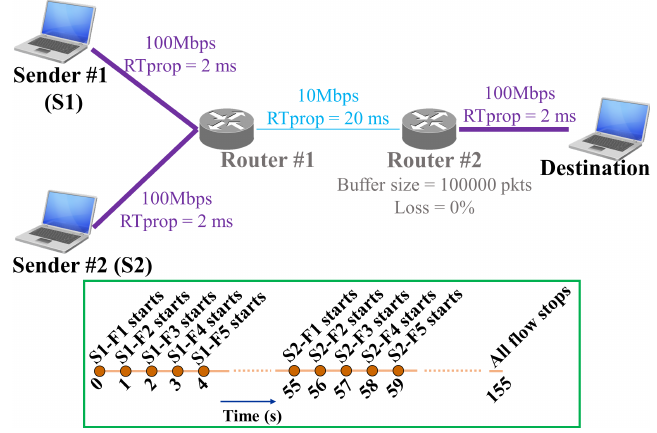
Figure 2. The setup and testbed